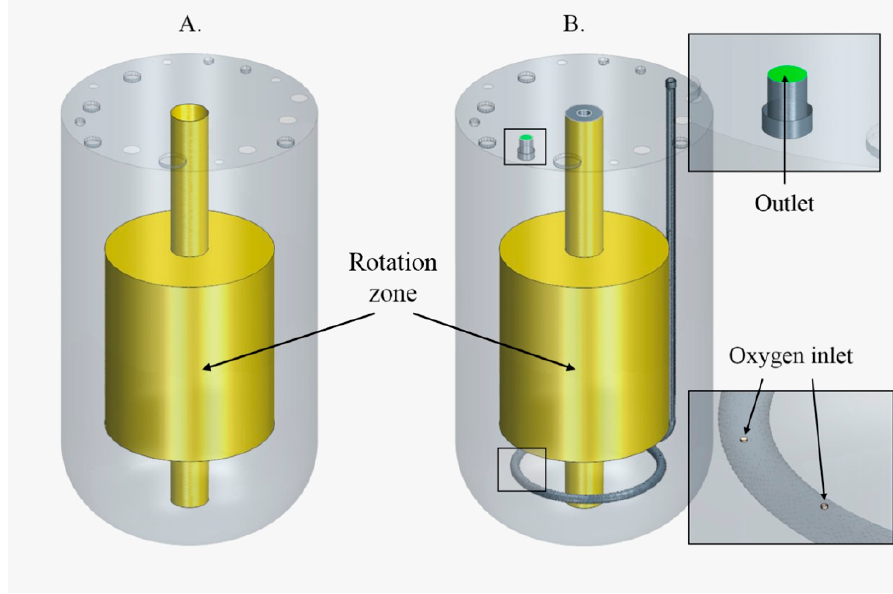
Figure 2. ( A ) Boundary conditions for the power analysis using a Moving Reference Frame (MRF) scheme. ( B ) Boundary conditions for the flow patterns analysis, with the inlet and outlet of air and the Rigid Body Motion (RBM) scheme. In both cases, the yellow area corresponds to the boundary location of the rotation zone.